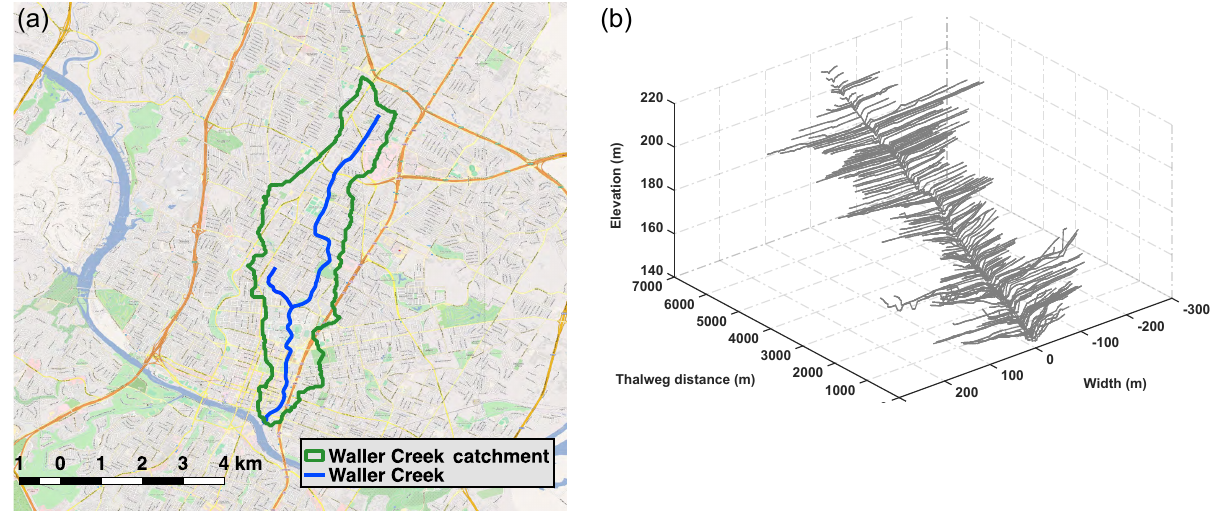
Figure 2. (a) Waller Creek and catchment in Austin (Texas, USA). (b) Surveyed cross sections of main channel for Waller Creek (Texas). Only 149 of 327 cross sections are shown for clarity. Elevations are relative to mean sea level (data courtesy of the City of Austin). Table 1. Cross-section geometry test cases. W B and S sw represent bottom width and sidewall slope, respectively; f represents the focal length of parabolic shape. Channel Number of Test length computational Cross-section Cross-section nodes shape type shape